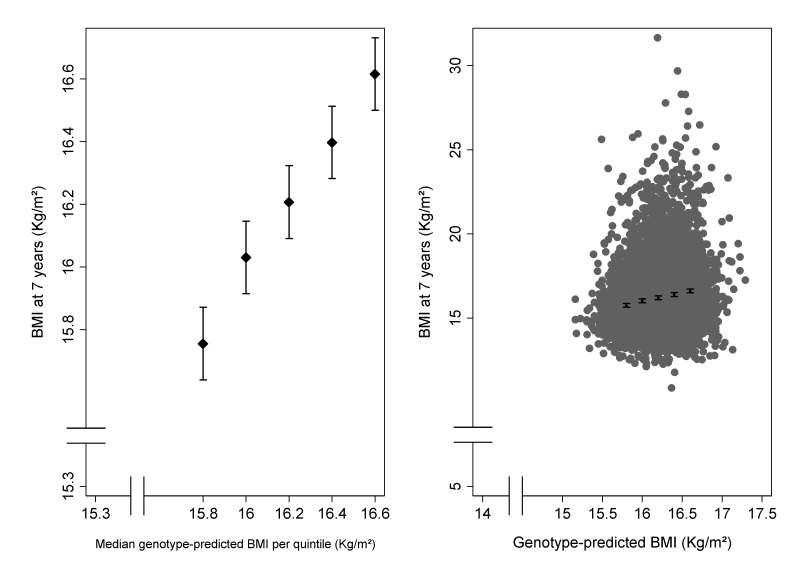
Association of BMI at 7½ y of 32 BMI-related SNPs.The left panel shows the mean BMI (with 95% CI) in groups defined by quintiles of genotype-predicted BMI. The right panel shows the same means and confidence intervals superimposed on the overall distribution of BMI plotted against genotype-predicted BMI.